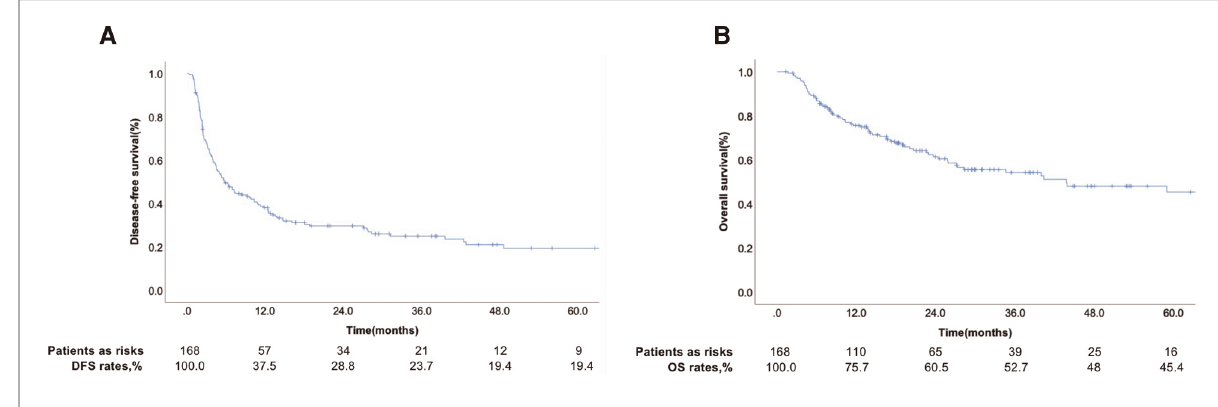
FIGURE 1 The disease-free survival ( A ) and overall survival ( B ) rate of patients with